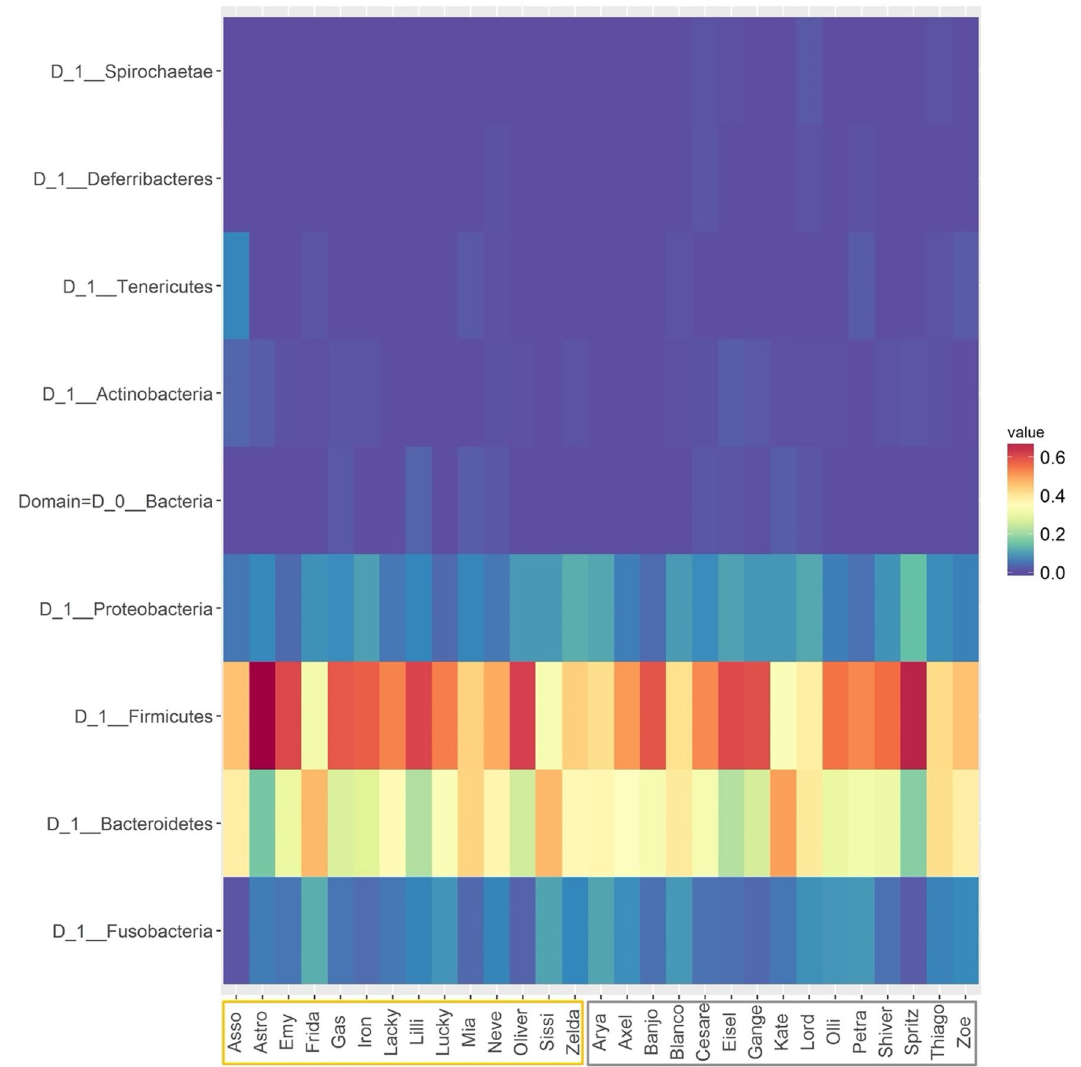
Figure 1. Heatmap displaying the relative abundance of predominant bacterial phyla in faecal samples belonging to the lean (grey box, n = 15) and overweight (yellow box, n = 14) canine populations, with individuals in rows and taxa in columns. Dogs’ names were used to distinguish the analysed samples. Colours represent relative abundances, the brighter the shade of red, the higher the abundance of the taxa. This figure was created using R version 3.4.3 (https:// www.r- proje ct. org).